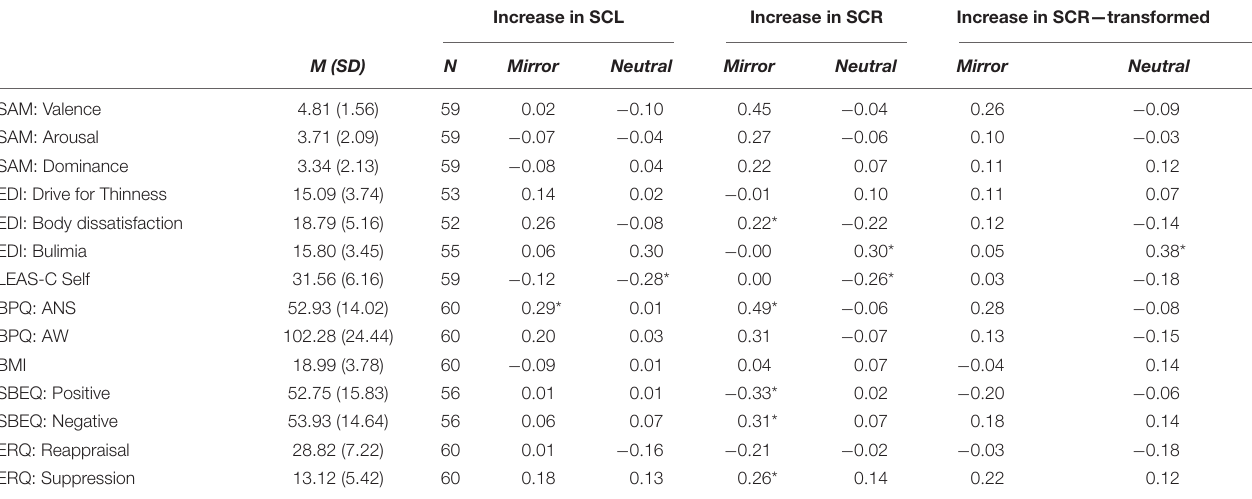
TABLE 4 | Correlations between psychological variables and the % increase in SC parameters in the NEUTRAL condition and the MIRROR condition (no Type I error correction applied). Increase in SCL Increase in SCR Increase in